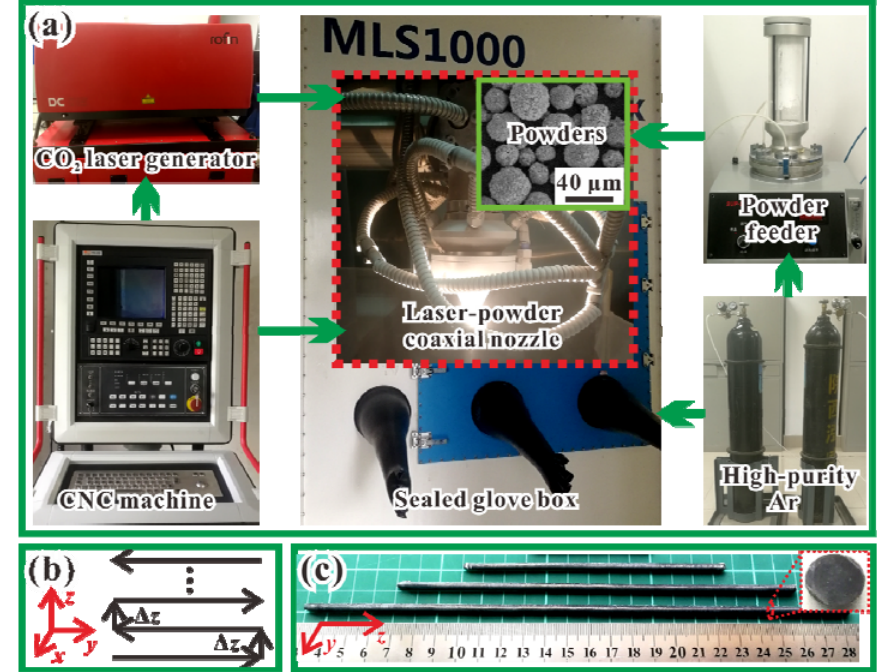
Fig. 1 Laser 3D printing process in this study: (a) applied laser 3D printing system, (b) scanning strategy, and (c) as-obtained Al 2 O 3 /GdAlO 3 /ZrO 2 ternary eutectic